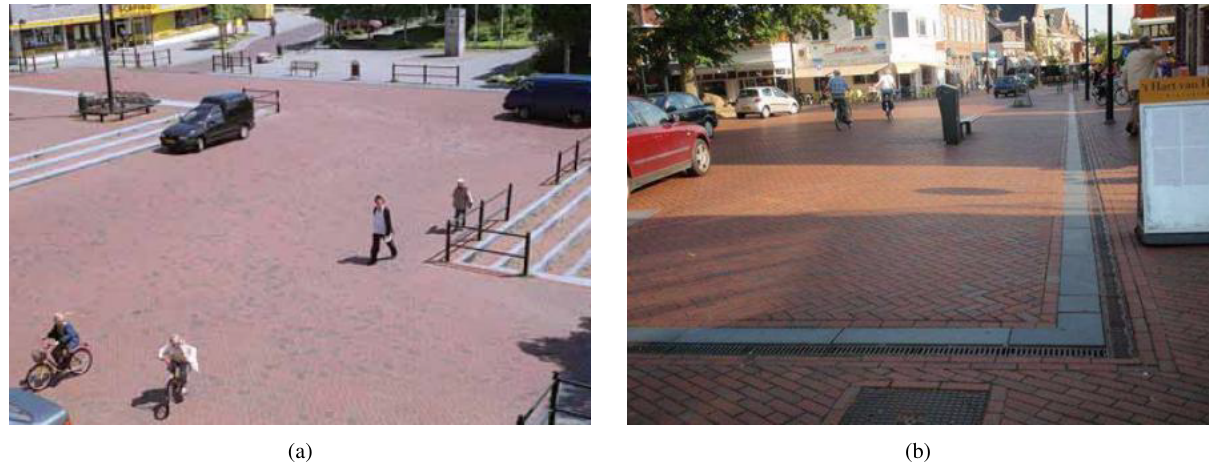
Figure 1: (a): Friesland, the Netherlands. A five way intersection with a shared level, traffic lights, sign and markings removed (Photo:(Hamilton-Baillie, 2004)), (b): Rijksstraatweg, Haren, the Netherlands. A shared level surface with paving creates a town square appearance with outdoor seating and restaurants (Photo: (Sutcliffe,